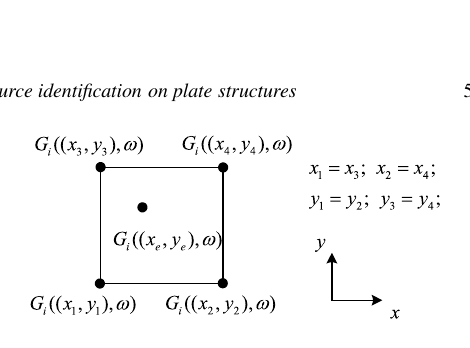
Fig. 4. Approximation of transfer function at estimated impact